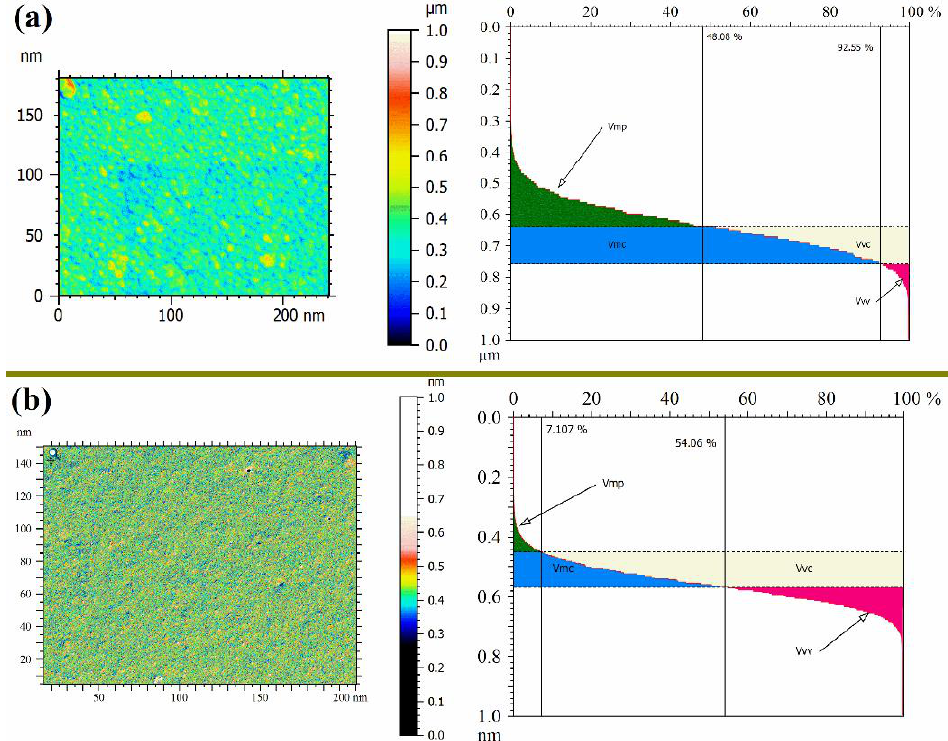
Figure 3. The surface porosity-view of the membranes ( a ) PPSU support, ( b ) PANI-deposited PPSU and denoted as peak material volume (Vmp), valley void volume (Vvv), core material volume (Vmc), and core void volume (Vvc).